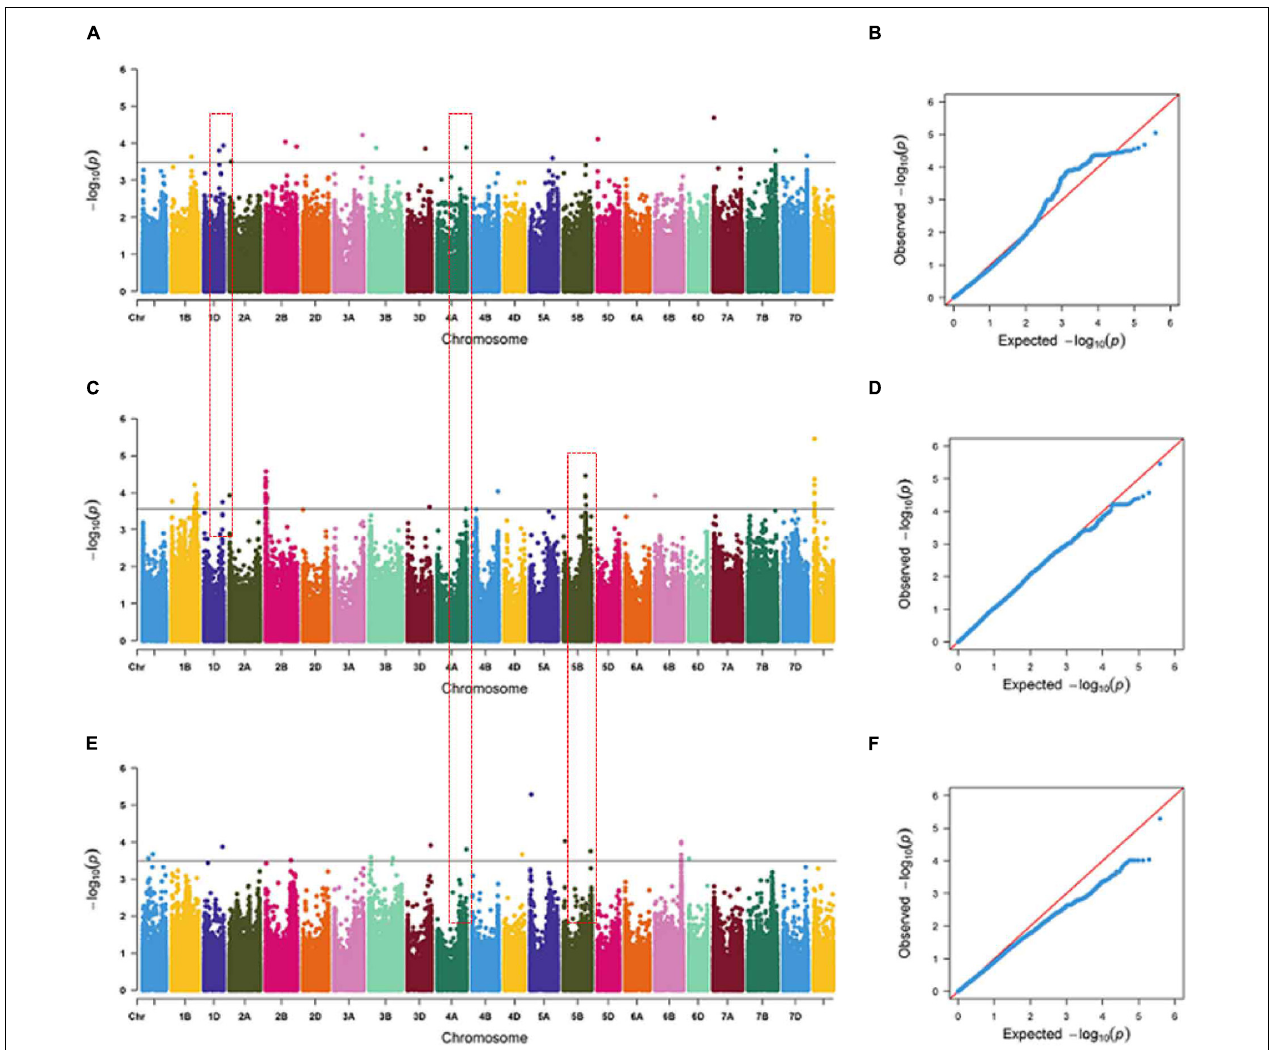
FIGURE 2 | Manhattan and Q-Q plots for total root length (TRL) under indoor hydroponic culture (A,B) , outdoor hydroponic culture (C,D) , and outdoor pot culture (E,F) . The chromosomes on the x -axis and –log 10 ( p ) values on the y -axis were all based on BLUE values. The gray line indicates the threshold of significance at –log 10 ( p ) = 3.5. The red text box represents the co-localization region among different growing